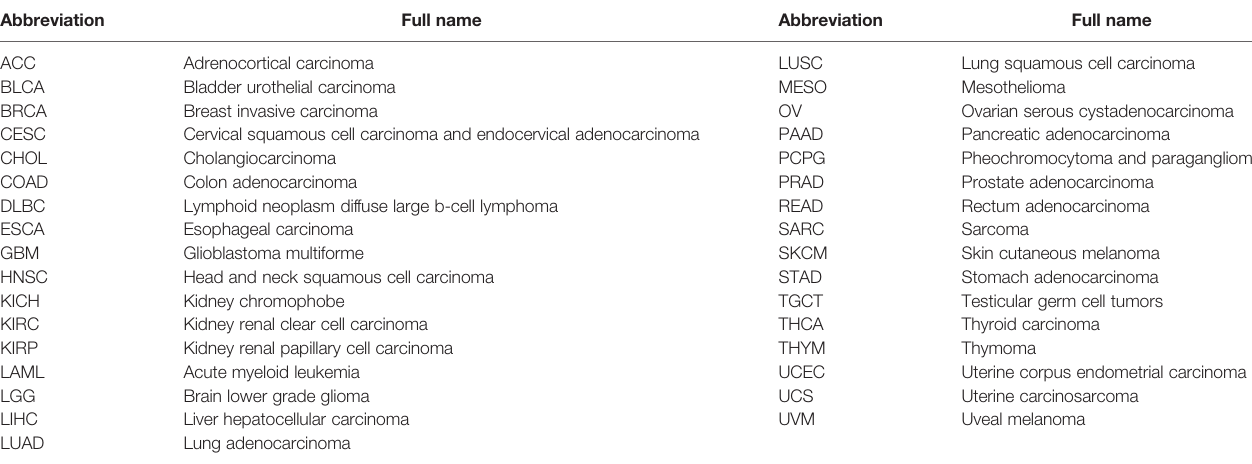
TABLE 1 | Abbreviations and full names of